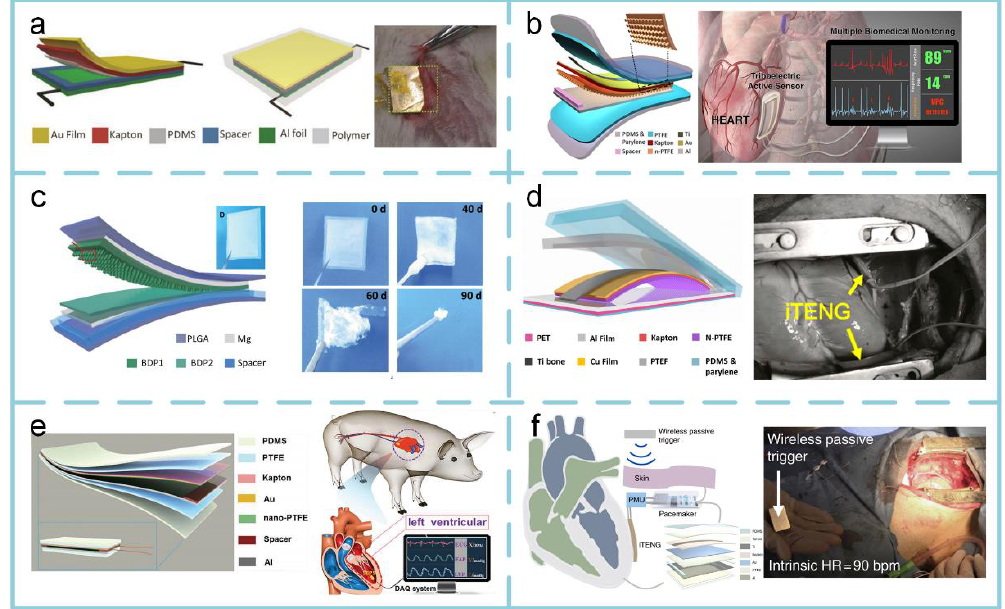
Figure 13. Implantable TENGs for biomedical and healthcare applications. ( a ) In vivo powering of a